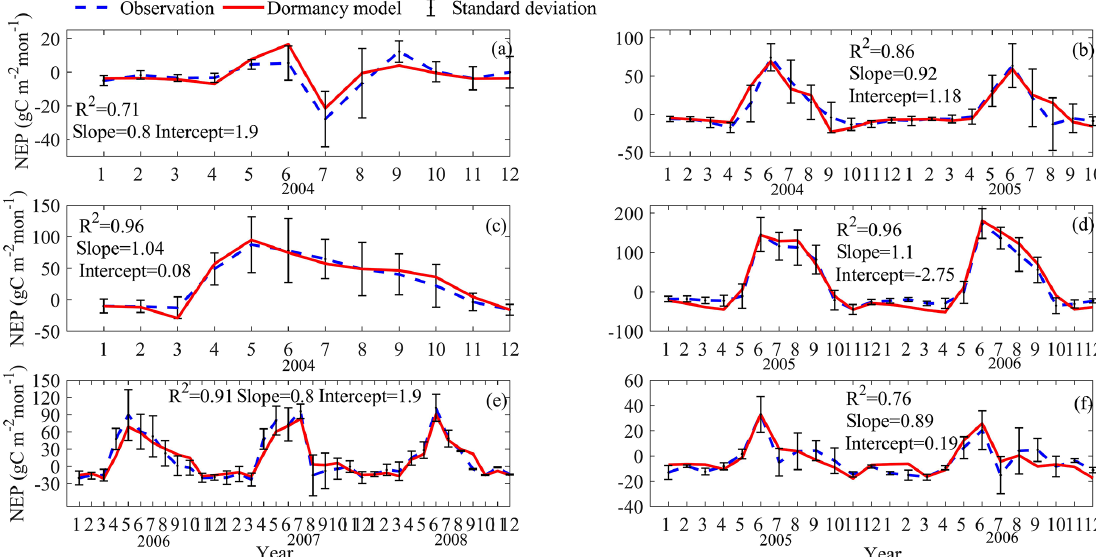
Figure 2. Comparison between observed and simulated NEP (gCm − 2 per month) at (a) Ivotuk (alpine tundra), (b) UCI-1964 burn site (boreal forest), (c) Howland Forest (main tower) (temperate coniferous forest), (d) Univ. of Mich. Biological Station (temperate deciduous forest), (e) KUOM turf-grass field (grassland), and (f) Atqasuk (wet tundra). Note: scales are different. Error bars represent standard errors among daily measured data in 1 month.